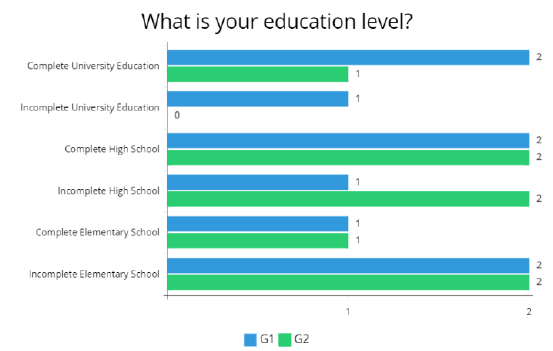
Figure 2. Education level of participants from G1 and G2